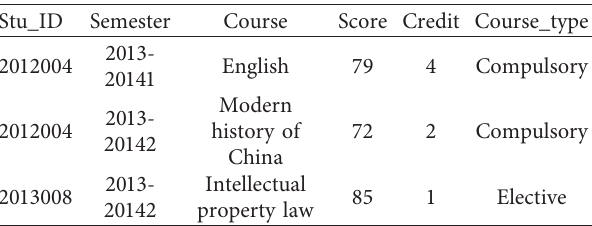
Table 5: Data format of grade